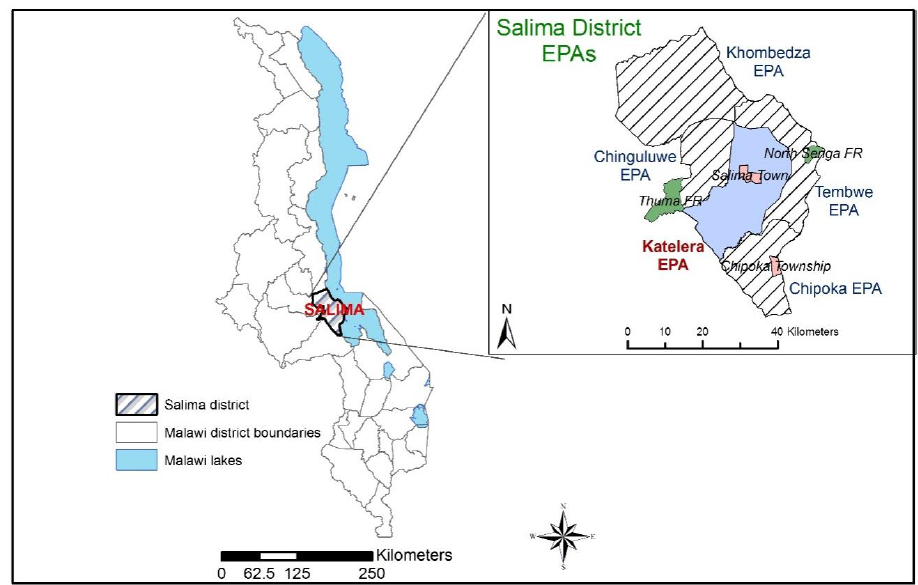
Figure 1. Map of Malawi showing the location of the study site in Salima District and Extension Planning Area (EPA).